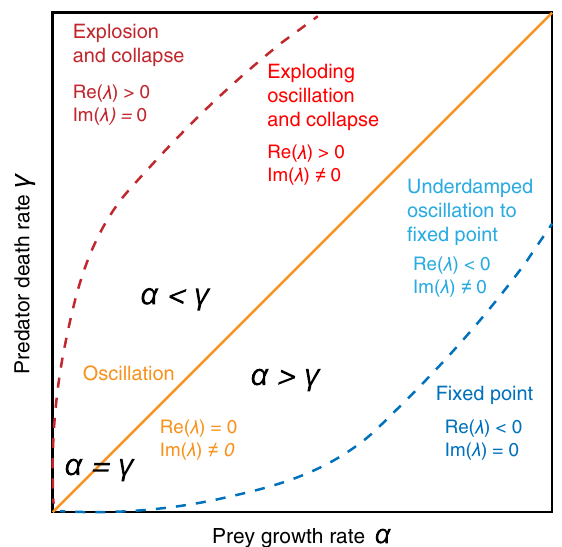
FIG. 11. Phase diagram obtained using the perturbation theory. Perturbation theory correctly predicts the phase boundary be- tween stable fixed points, unstable fixed points, and sustained oscillation ( α ¼ γ , yellow line). However, it incorrectly predicts the phase boundaries that distinguish the oscillating from non- oscillating approach to the fixed points (broken blue and crimson lines) at small α and γ . A key drawback of the perturbation theory is that it does not account for the sigmoidal nature of κ ð Φ Þ and its saturation at κ , which removes the nonoscillating regions max (explosion and collapse and fixed point) from the phase diagram.